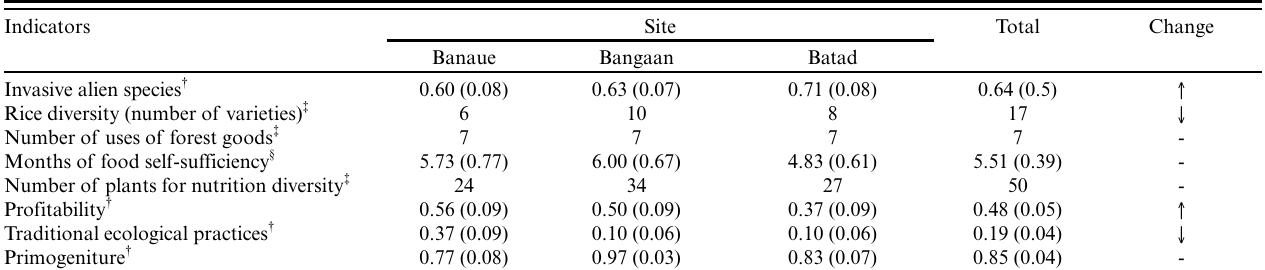
Table 3 . Values for indicators of the state of the social-ecological system in Banaue. Changes in the value of each indicator as compared to the baseline values (see Table 1 for definitions and values) are shown as arrows ( ↑ = higher value; ↓ = lower value; - = no change). Indicators Site